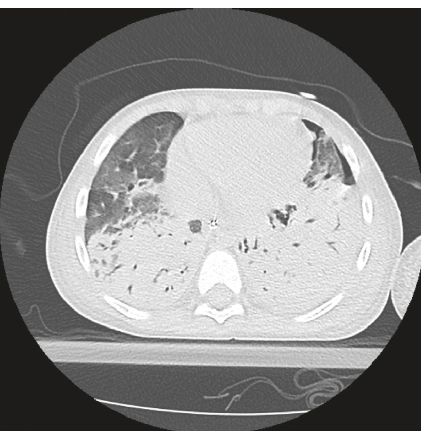
Figure 2: Computed tomography image revealing dense consol- idation and pneumothorax. The clinical findings were in keeping with bronchopleural